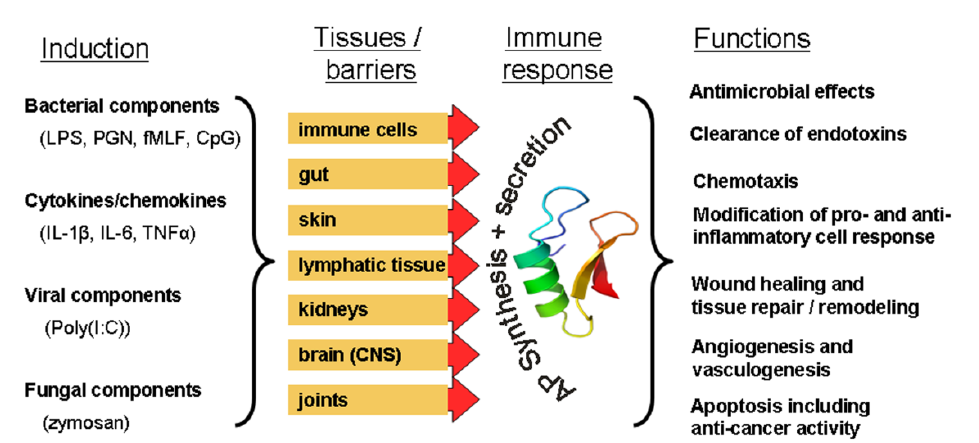
Figure 2. Induction, examples of localization and potential biological roles of antimicrobial peptides